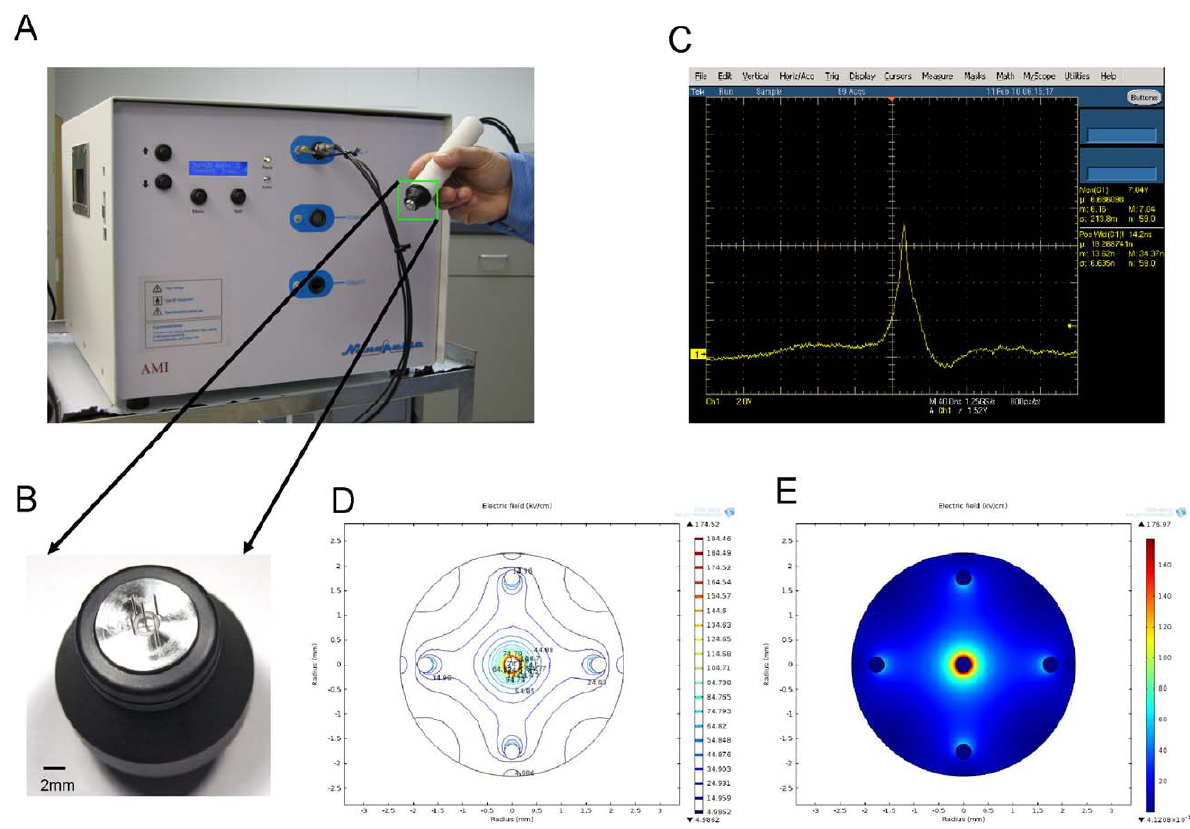
Figure 7. Nanosecond pulsed electric field generator. Image showing the experimental nanosecond pulsed electric field generator and hand piece for delivery of nsPEF exposure to skin tumors in vivo (Panel A ). Enlarged image showing nsPEF delivery tip; the tip is placed into the tumor during exposure. Significant components of the tip include five short 30-gauge needle electrodes, the center electrode being the positive with four surrounding return electrodes, each spaced 1.75 mm from the center electrode (Panel B ). Image showing typical pulse waveform, with 7KV amplitude and 14 ns pulse width (FWHM) delivered into a fixed 100 ohm load (Panel C ).